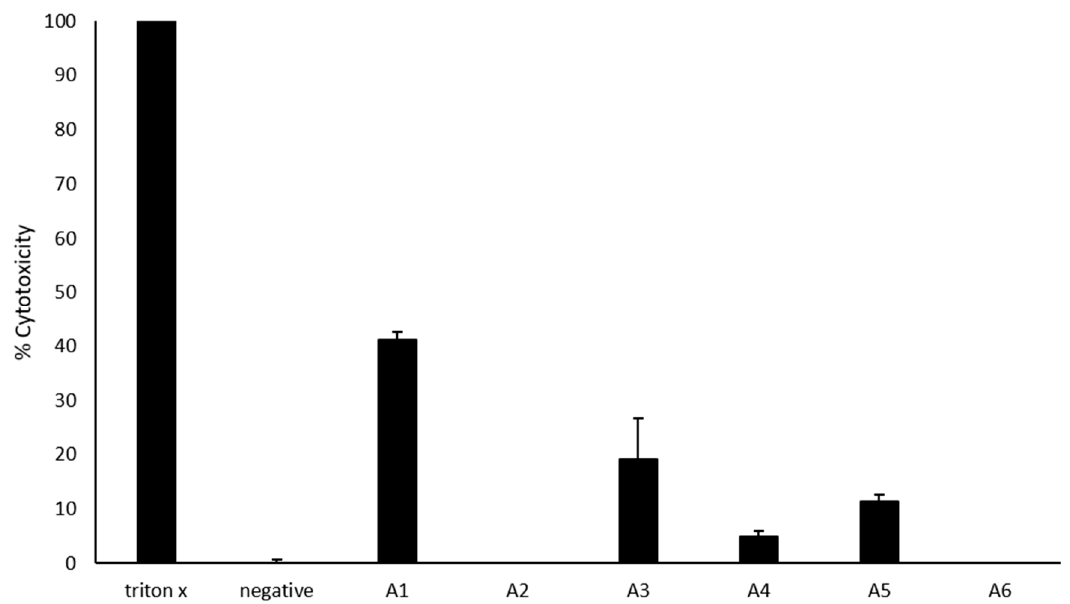
Figure 3. Cytotoxic effects of azoles against host cells. Briefly, 50 μ M azoles were incubated with HaCaT cells monolayers for 24 h at 37 °C in a 5% CO 2 incubator as described in Materials and Methods. The results showed that most azoles have limited host cell damage. The data are presented as the mean ± standard error.